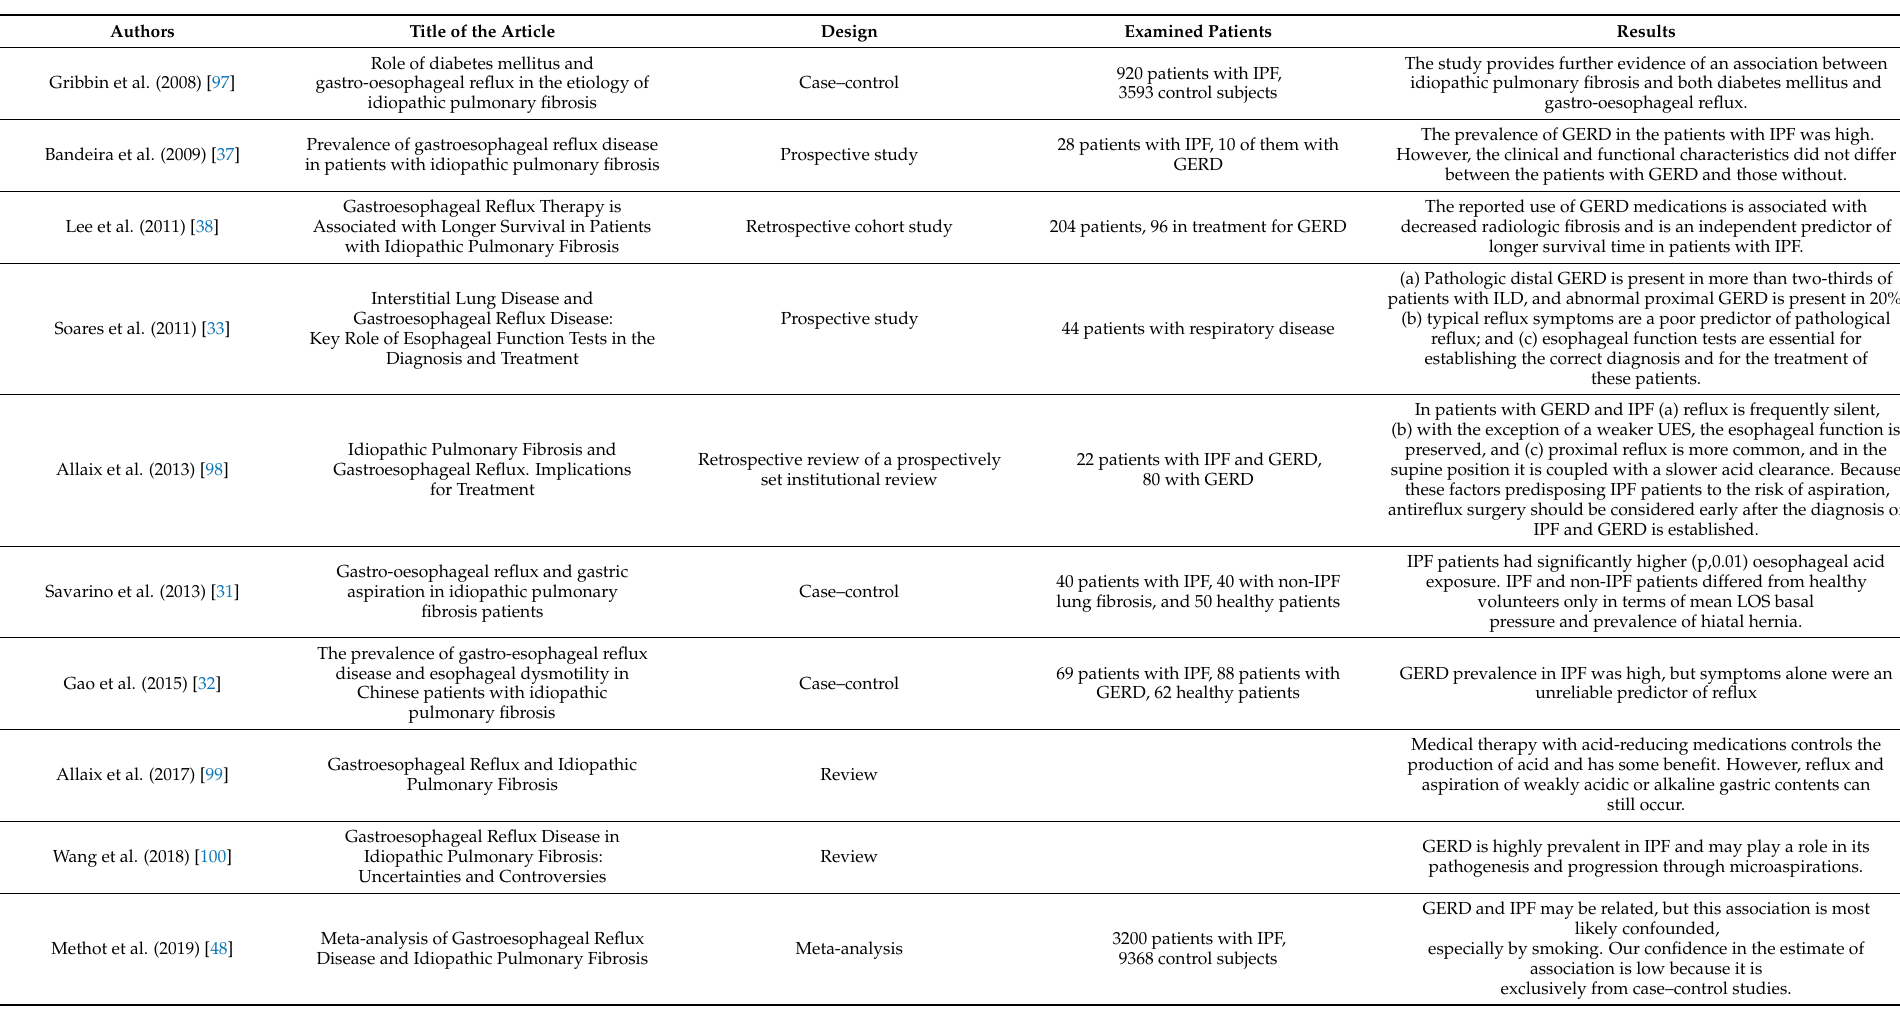
Table 2. Table of the studies which investigated the strict relationship between GERD and IPF, which were included in this systematic literature